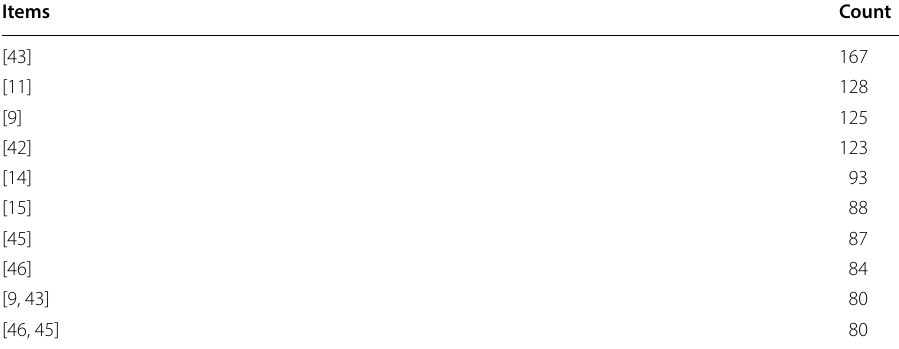
Table 2 Frequent itemsets Items